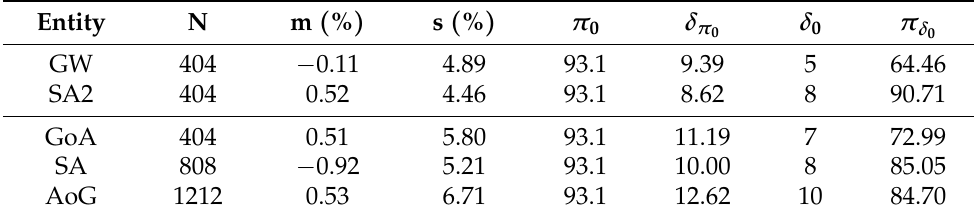
Table 3. Performance for all T2S3 (Class